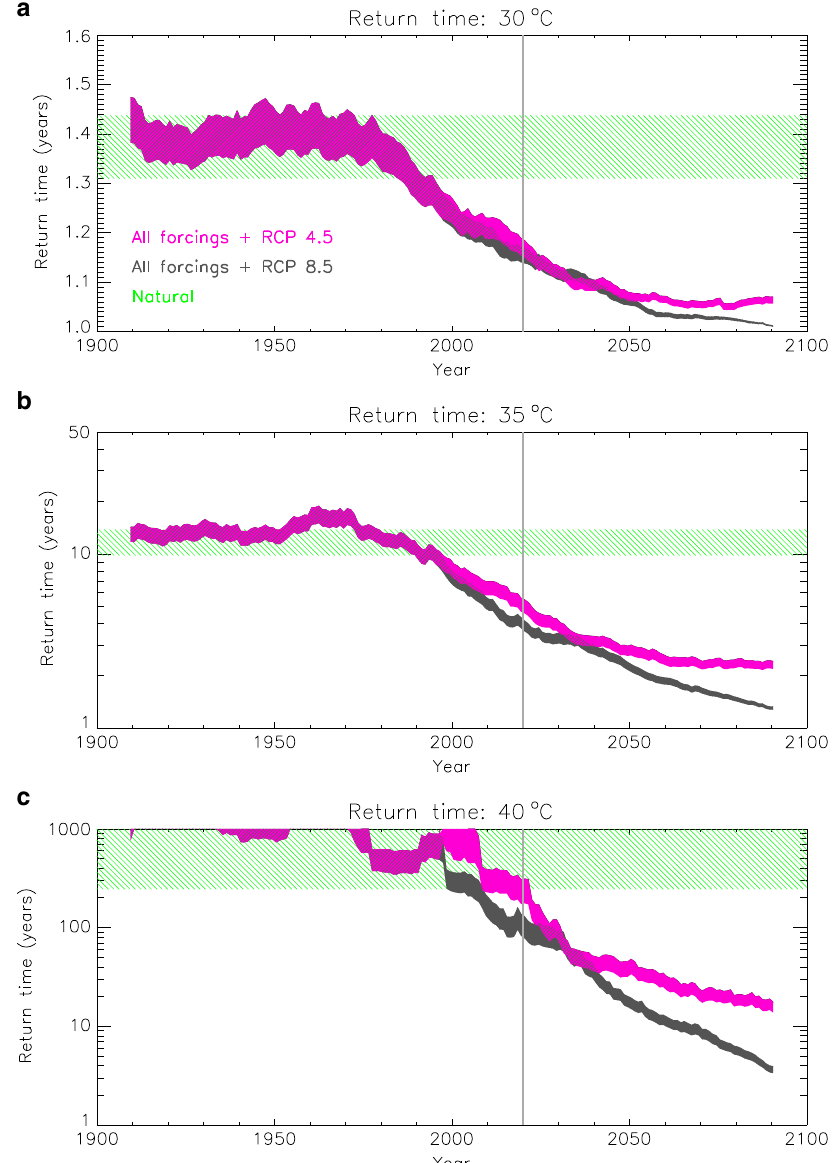
Fig. 8 The increasing likelihood of exceeding high temperature thresholds anywhere in the UK. Timeseries of the return time for observing temperatures in the UK above a 30 °C, b 35 °C and c 40 °C with all forcings and future projections following the RCP 4.5 (in pink) and RCP 8.5 (in grey) scenarios. The thickness of the timeseries illustrates the uncertainty in the transfer functions used in the analysis. The expected range in the natural climate is marked in green. The vertical grey lines mark year 2020 (i.e., the present